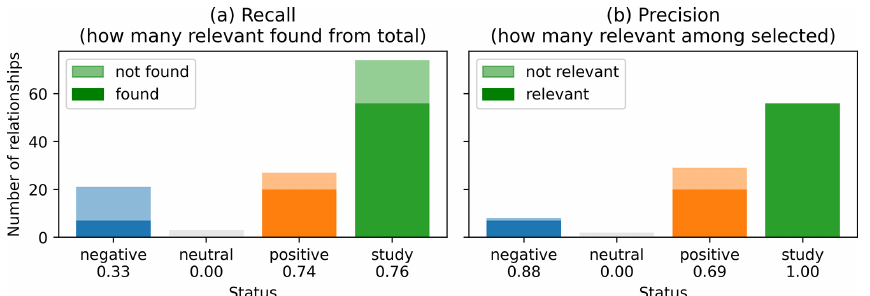
Figure 8. Recall (a) and precision (b) of classified relationships extracted from abstracts. Dark color represents the proportion of relationships correctly classified, while the faded color represents relationships not found or not correctly classified. The recall and precision metric for each category is given on the x axis. Results were obtained for the Meta corpus.